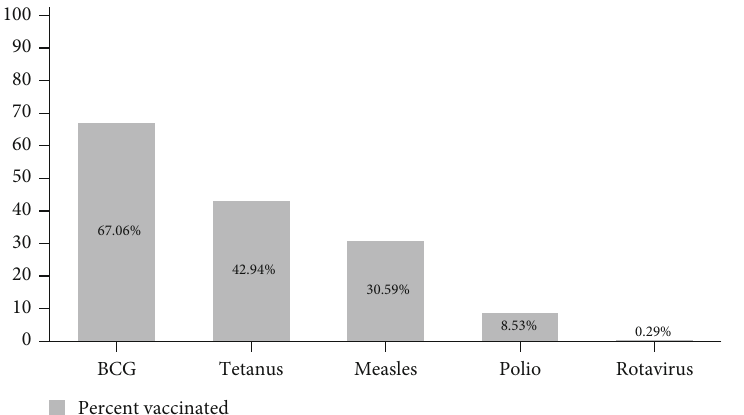
Figure 1: Results of vaccination survey in rural Northwestern Madagascar. 69.4% of the population in this region remains unvaccinated for measles. Vaccination rates for other major infectious diseases remain similarly